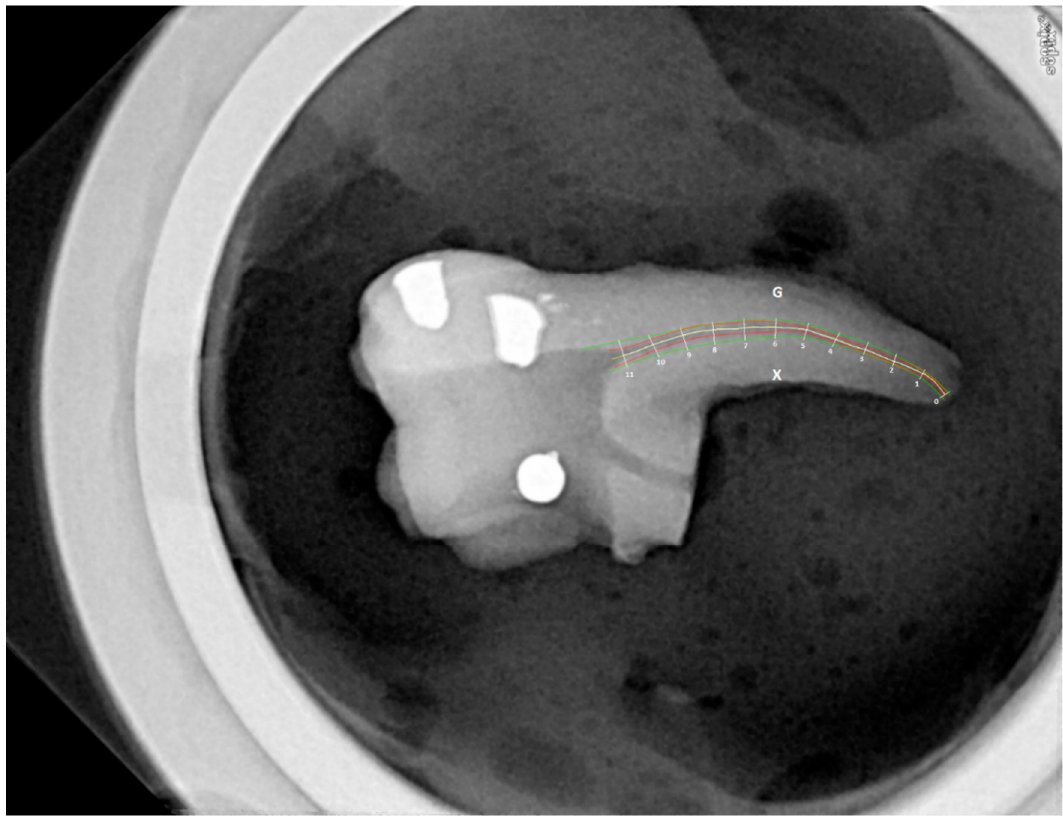
Appl. Sci. 2021 , 11 , 6599 Figure 3. Composite image showing the before instrumentation and after instrumentation tracings.